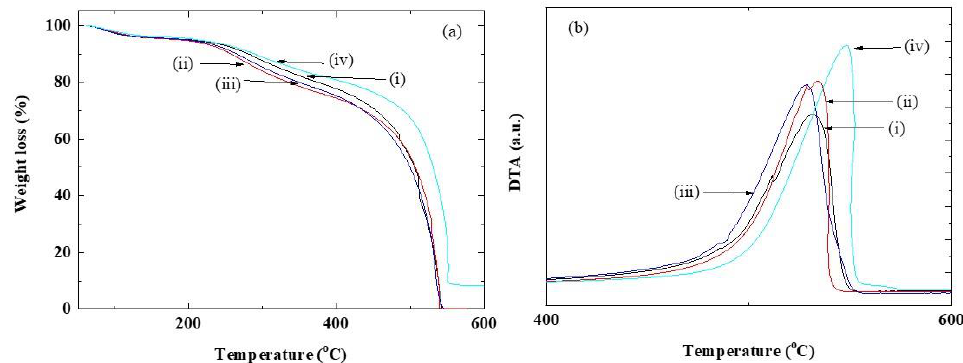
Figure 3. ( a ) TG (thermal gravimetric) and ( b ) DTA (differential thermal analysis) results of (i) CSPPSU-5vinylon, (ii) CSPPSU-10vinylon, (iii) CSPPSU-20vinylon, and (iv) CSPPSU membranes. Table 3. Summary of temperature ranges and mass losses observed for each step in the TG-DTA curves for CSPPSU-vinylon membranes.